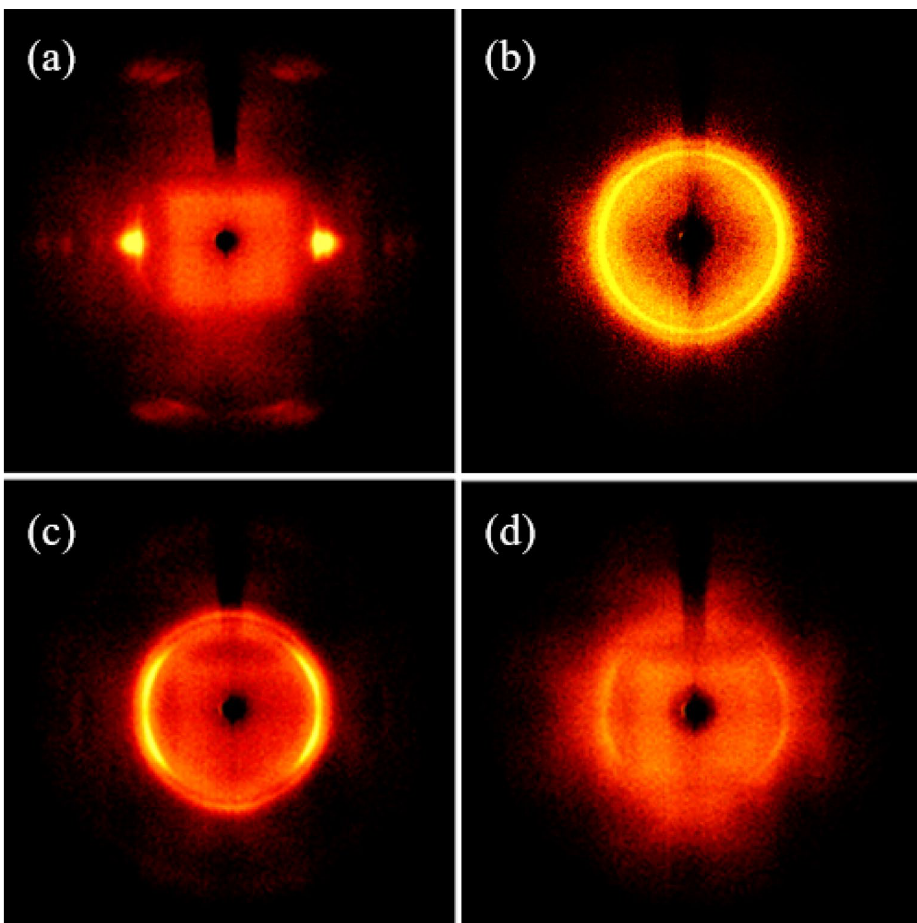
Figure 9. 2D-WAXD pattern of LLDPE precursor fibers and sulfonated LLDPE fibers with melt flow index of 20 at a sulfonation time of 2.5 h under a pressure of 5 bar and temperature of 130 °C ( a ) FL20, ( b ) FSL20, ( c ) PL20, ( d ) PSL20.